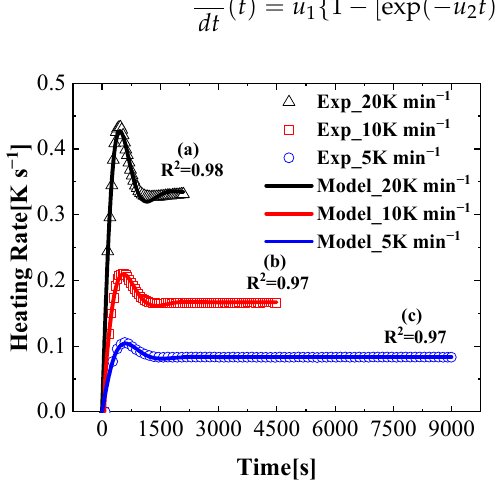
Table 2. Parameters of the exponentially decaying trig function.